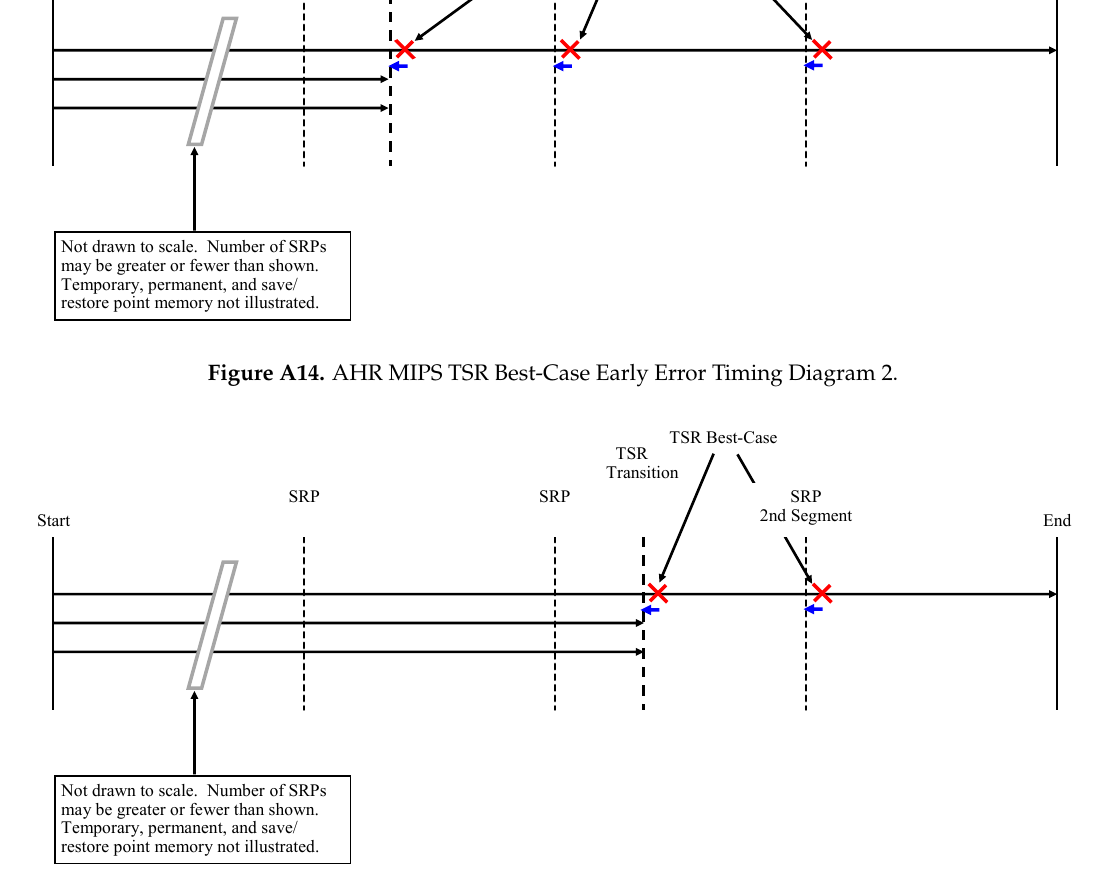
Figure A15. AHR MIPS TSR Best-Case Early Error Timing Diagram 3.